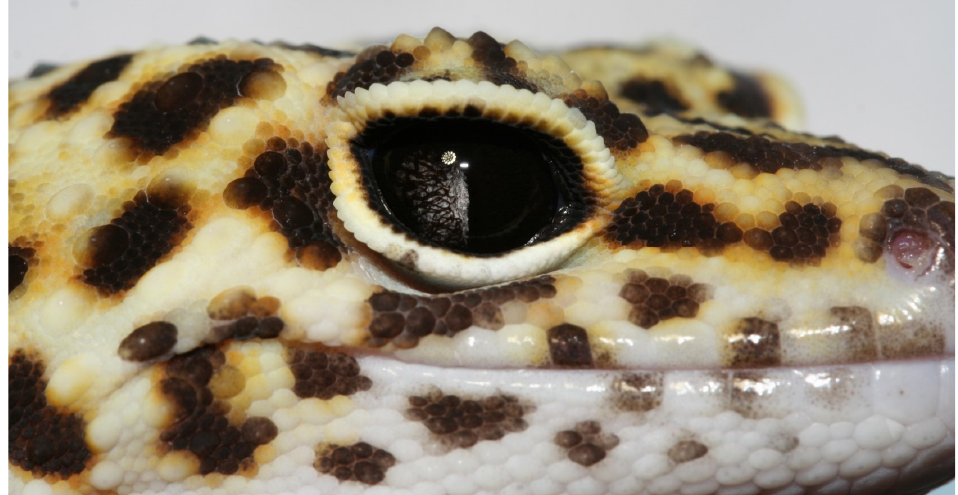
Figure 3. Members of the eublepharid clade, such as this leopard gecko ( Eublepharis macularius ), are the only Gekkota that possess fully moveable eyelids.